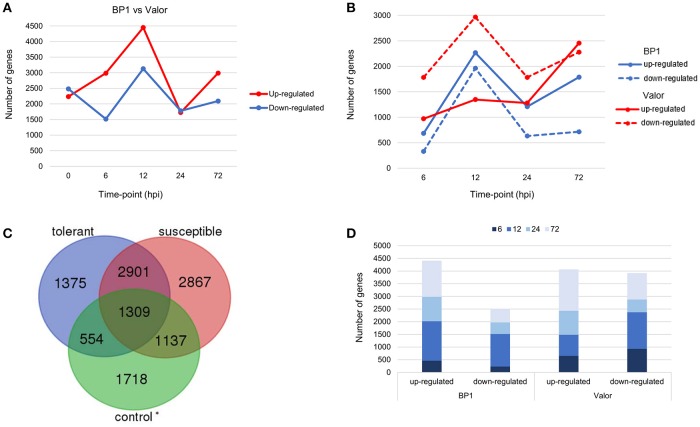
(A) Pairwise comparison of DEGs in cultivars “Valor” and “BP1” in the time-course showing number of DEGs up- and down-regulated in cultivar “BP1” compared to cultivar “Valor.” (B) Cultivar specific DEGs between inoculated samples and mock-inoculated controls in each cultivar independently. (C) In total, 1929 and 4004 DEGs were identified and are specific to the tolerant and susceptible cultivar, respectively. Of these, 554 and 1137 DEGs in “BP1” and “Valor,” respectively, represent intrinsic cultivar differences, and are related to plant growth and/or development (Table S5). In addition, 4210 DEGs were present in both cultivars in the time-course. *Control group represents DEGs obtained between “BP1” and “Valor” at 0 h time-point. (D) Graph showing DEGs up- or down-regulated in both cultivars at individual sampling time-points (6, 12, 24, and 72 hpi).